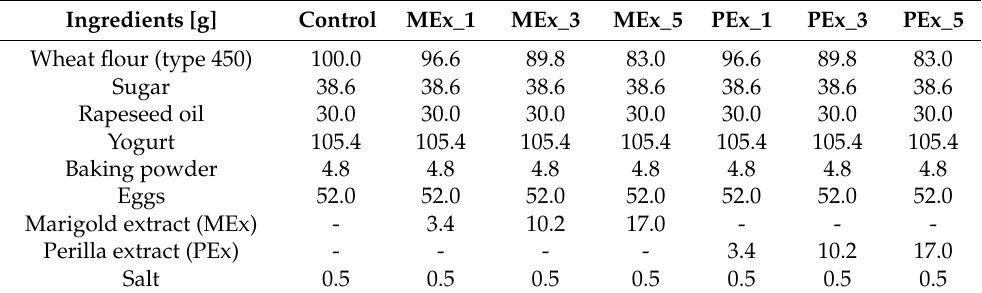
Table 1. Composition of used muffin formulations expressed on a 100 g of flour or 100 g of flour with extract